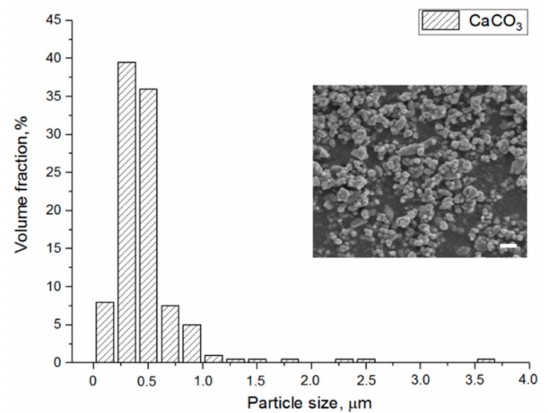
Figure 1. CaCO 3 particle size distribution and SEM image of the particles. Scale bar 1 µ